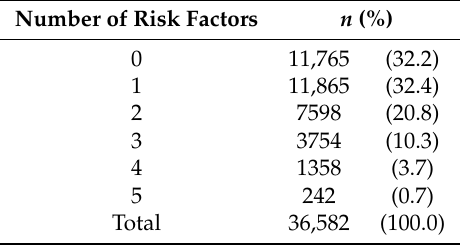
Table 1. Number of Metabolic syndrome Risk